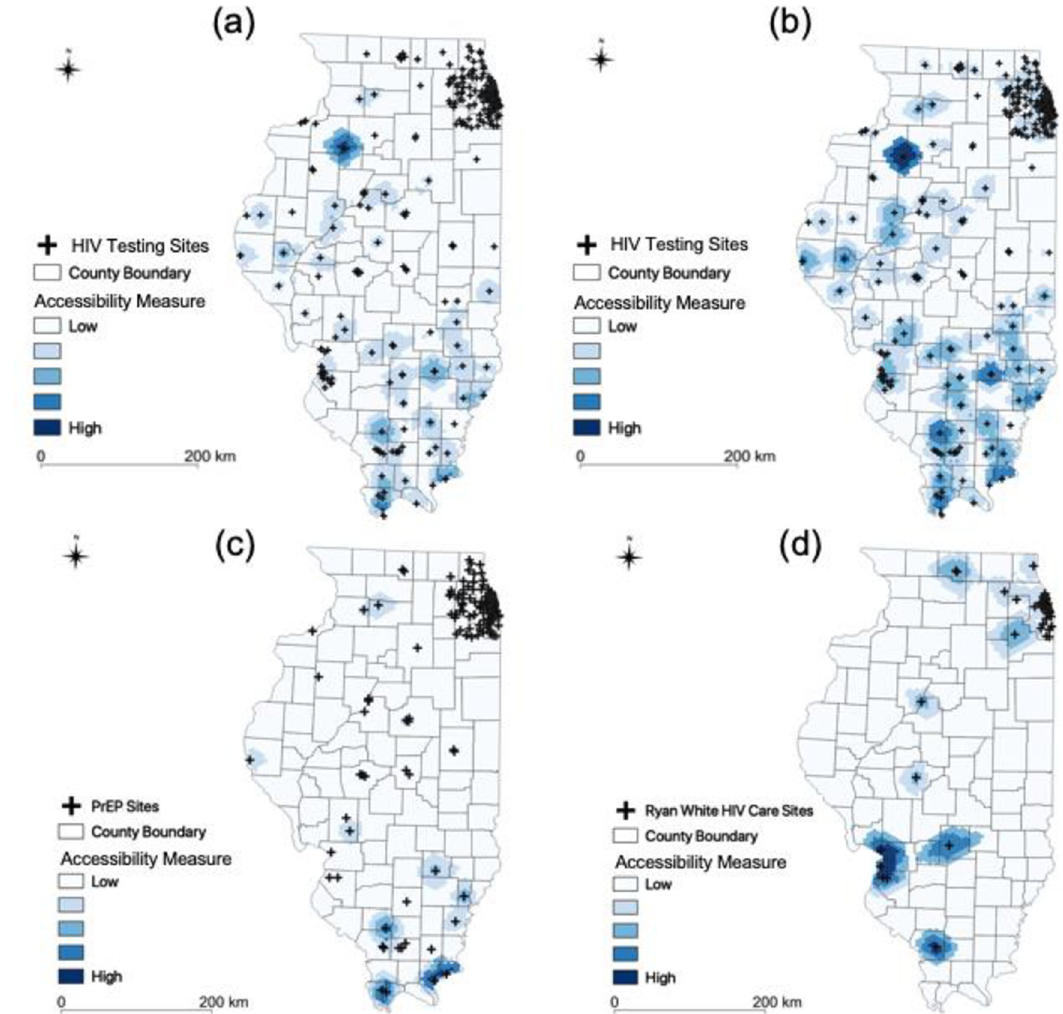
Fig 6. Spatial accessibility in Illinois. (a) Testing for MSM; (d) Testing for people aged 15 to 64; (c) Prevention for MSM; (d) Treatment for PLWH.